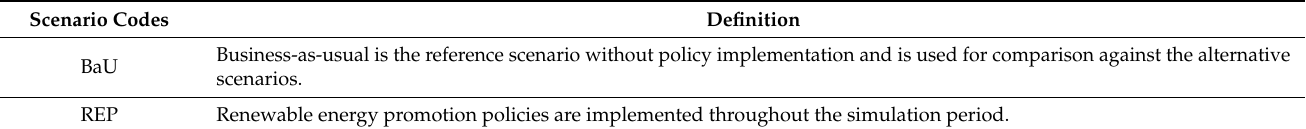
Table 2. Overview of scenarios used and what they mean.